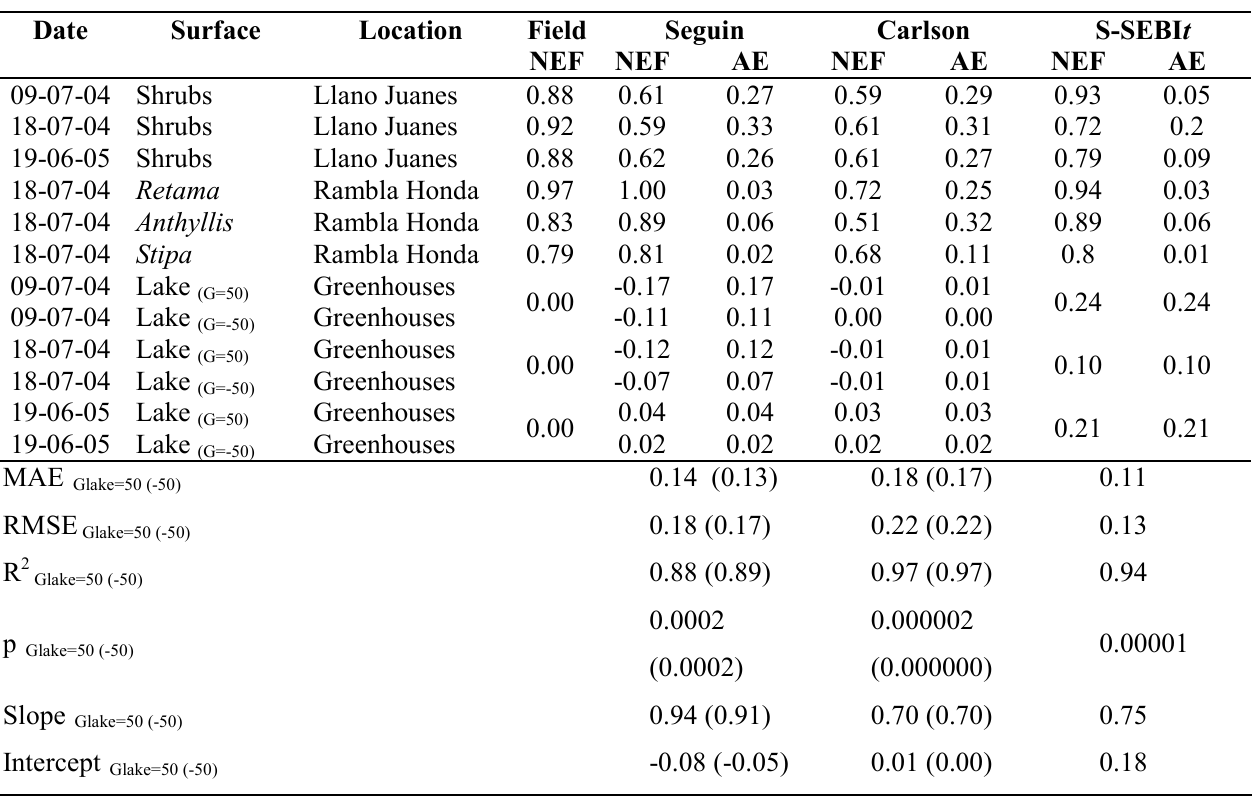
, NEF Seguin Carlson =50 Wm -2 lake